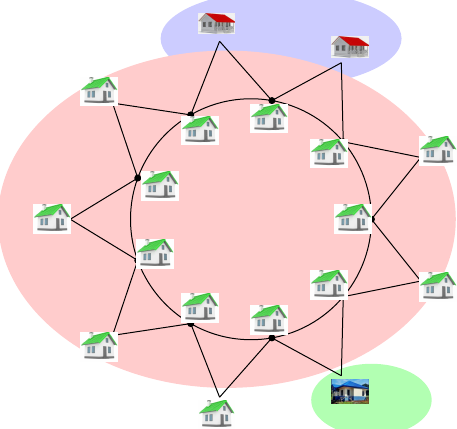
Figure 3. f 9 × 3 for partition